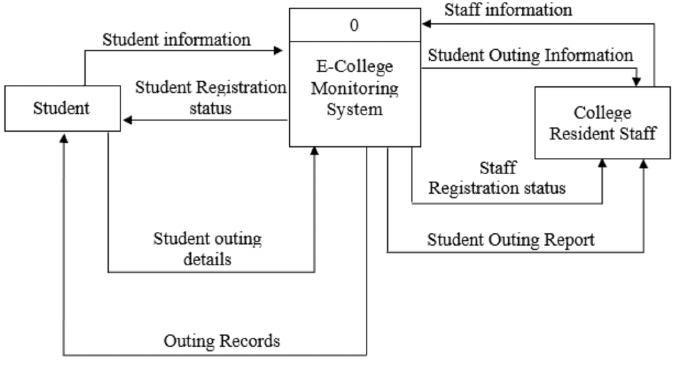
Figure 1. Context diagram.